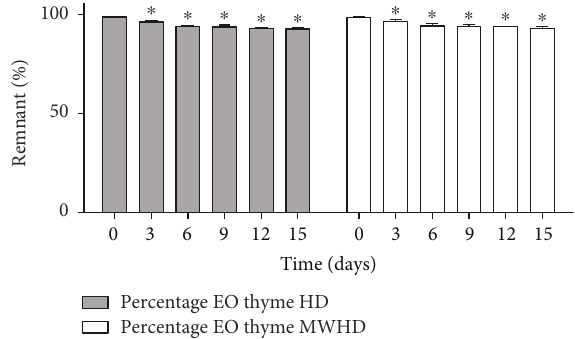
Figure 8: Remnant percentage of thyme essential oil in a 15- day aging, compared to the original composition. ∗ Signi fi cant di ff erences compared to day 0 p < 0 05 .